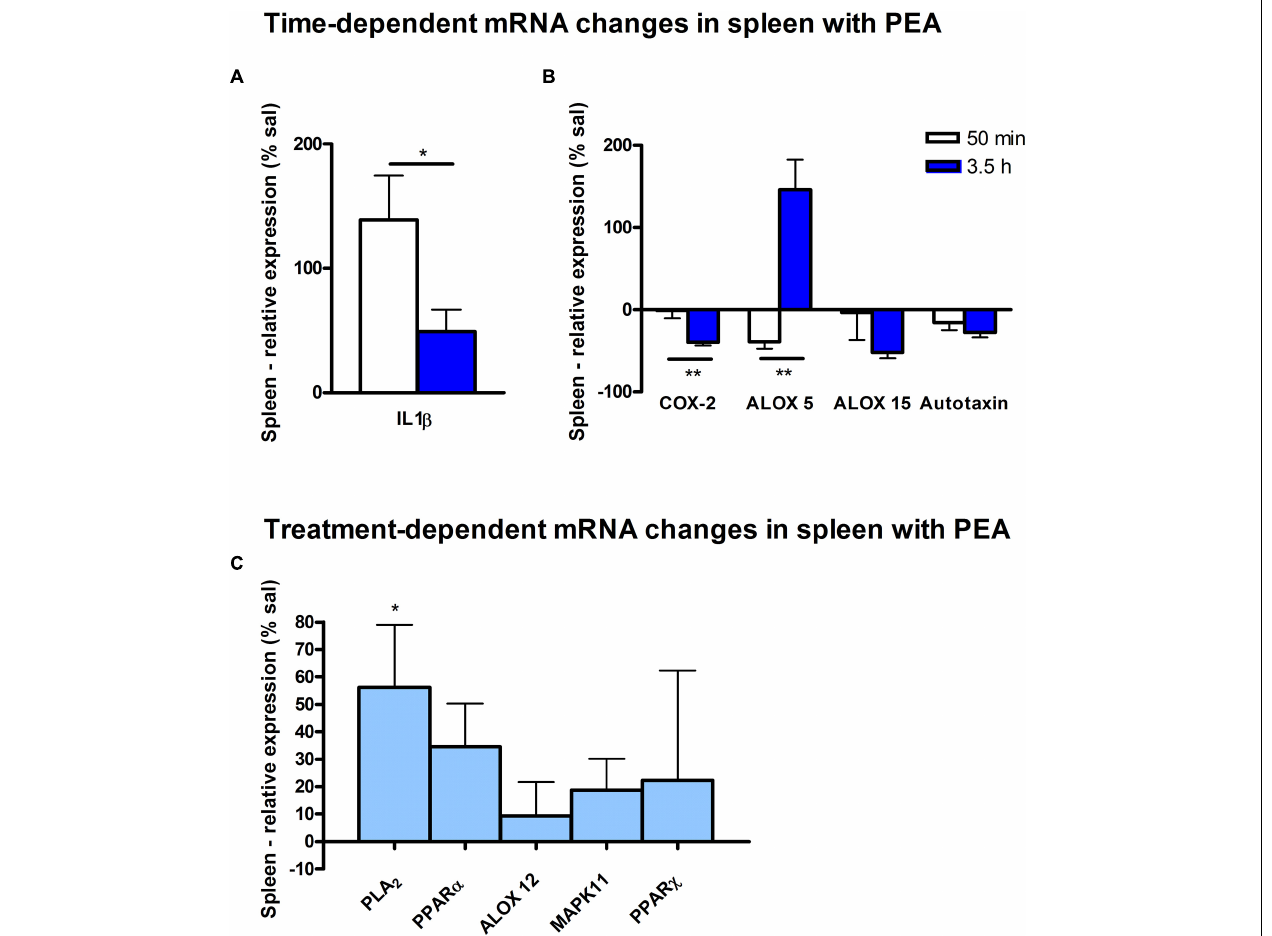
FIGURE 7 | mRNA levels of spleen after PEA treatment: relative mRNA values after PEA treatment as percentage of saline-treated mice, presented as mean value ± SEM. (A) Time point 1: time specific mRNA changes after 50 min of sub-chronic PEA treatment. Relative mRNA levels for two different time points are shown and only genes significantly changing after 50 min of PEA treatment are depicted. (B) Time point 2: time-specific mRNA changes after 3.5 h of PEA treatment. Relative mRNA levels for two different time points are shown and only genes significantly changing after 3.5 h of PEA treatment are depicted. Significant differences between the time points underline time specificity for these mRNAs and are depicted on the graph when occurring. (C) Merged time points: relative mRNA levels for merged time points. Changes for cPLA 2 are significant when pooling the time points. Data were considered significant at a p -value < 0.05, e.g., ∗∗∗ p < 0.001, ∗∗ p = 0.001 to 0.01; ∗ p = 0.01 to